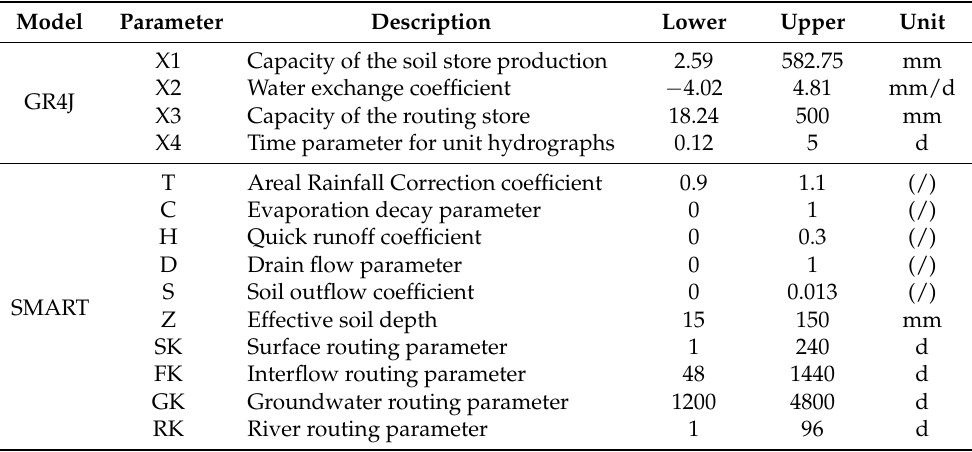
Table 2. Range of GR4J and SMART hydrological model parameters used for the sampling parameter